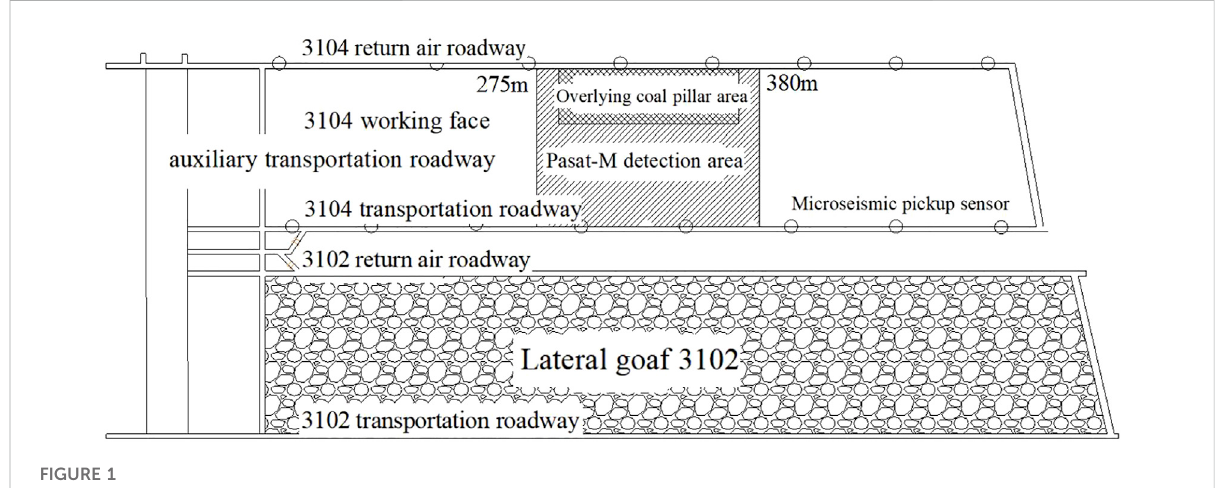
FIGURE 1 Mining engineering plan.